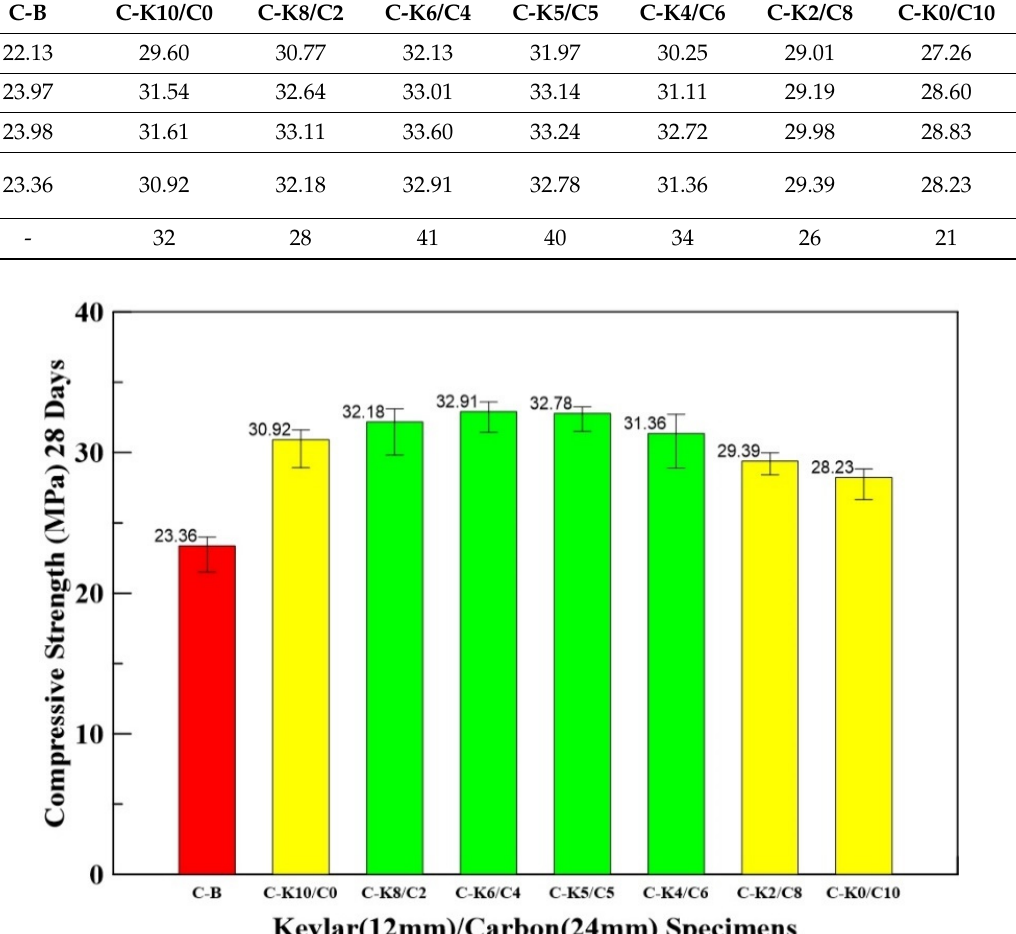
Figure 6. Bar chart for average compressive strengths of benchmark and Kevlar/carbon HFRC 267 specimens. 268